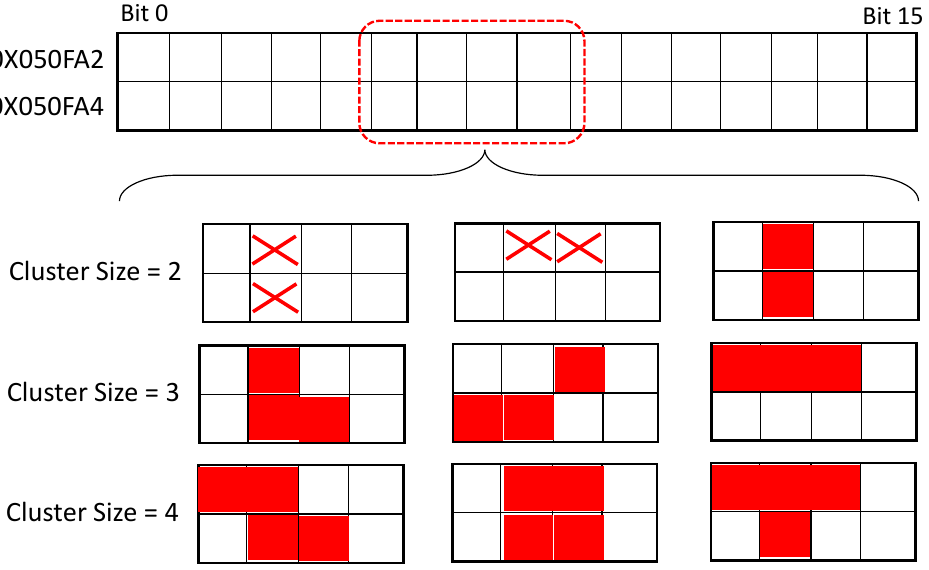
Figure 1. The observed Cluster SEMU pattern during the radiation test. The sensitivity rate of each cluster configuration, represented as cross-section sensi- tivity has been calculated and represented in Figure 2. As it can be observed, the cluster configuration with the two adjacent bits corrupted by a single particle is the case with the highest